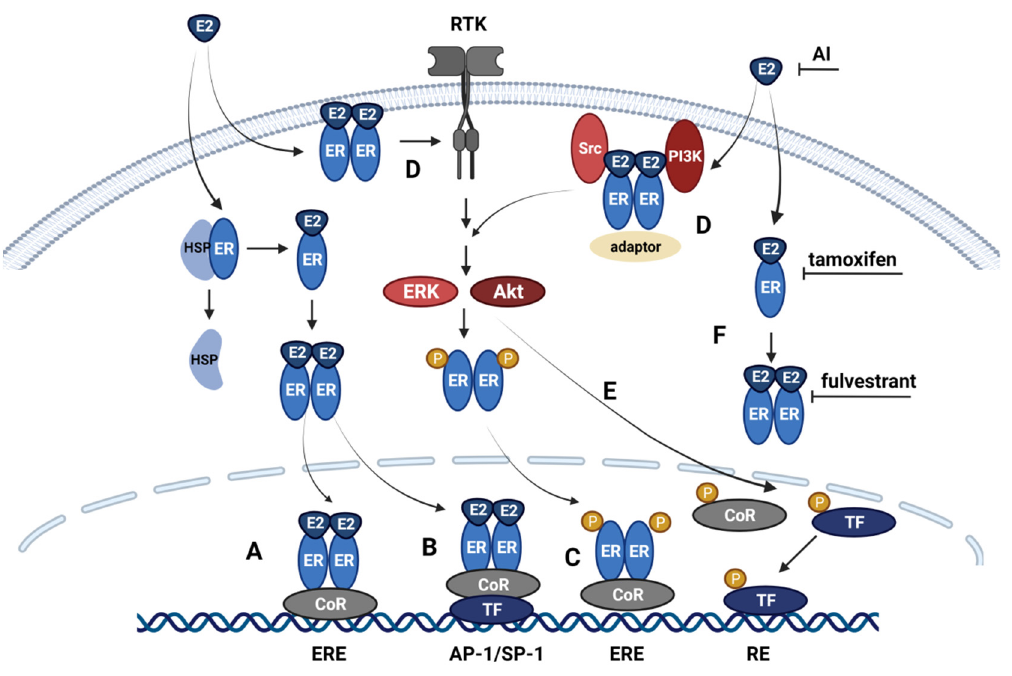
Figure 2. Mechanism of estrogen signaling and its inhibition by endocrine agents in breast cancer cells. ( A ) Classical genomic pathway. Estrogen (E2) upon binding to the estrogen receptor (ER), translocates to the nucleus, where it binds to estrogen response elements (EREs) within target genes. Coregulators (CoR) recruited to ER modulate gene expression. ( B ) Genomic, non-classical pathway. ER in the nucleus binds to target genes indirectly through interactions with transcription factors (TF). ( C ) Genomic, ligand-independent pathway. ER is activated by phosphorylation induced by kinases activated upon receptor tyrosine kinase (RTK)-mediated signaling. ( D ) Non-genomic, ligand pathway. Membrane-associated ER-bound with E2 activates RTKs and protein kinase cascades, which can also activate transcription factors modulating gene expression. ( E ) Convergence of non- genomic and genomic signaling. Activation of RTKs and protein kinases by ER-E2 complexes lead